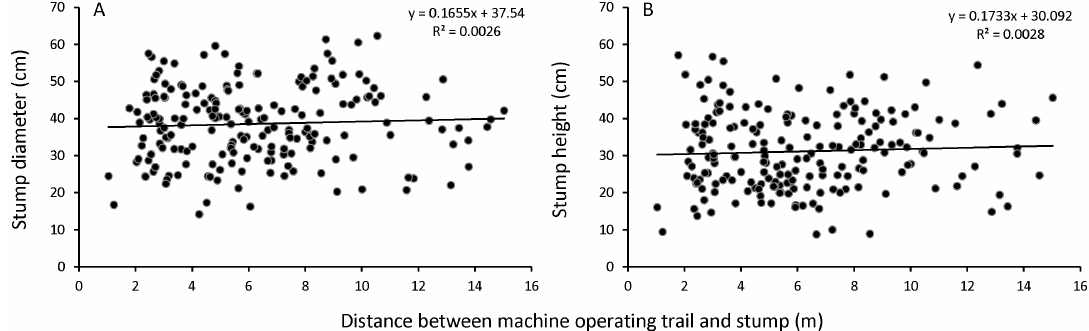
Figure 6. Relation between ( A ) stump diameter and distance to machine operating trail; and ( B ) stump height and distance to machine operating trail.